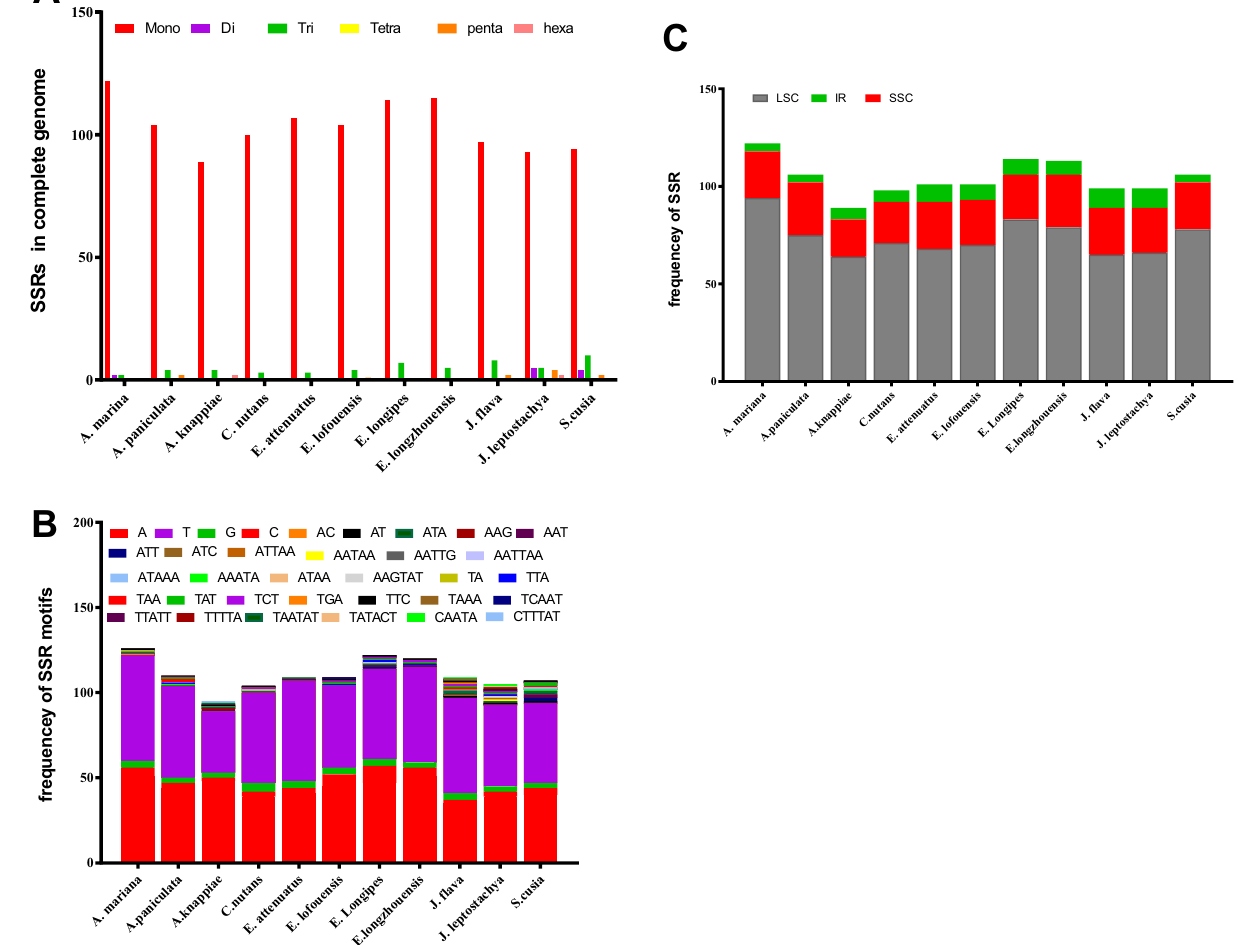
Figure 3. Simple sequence repeats (SSRs) analysis in the chloroplast genome of A. marina . ( A ) Numbers of SSR types in complete chloroplast genome, ( B ) Number of SSRs in LSC, IR and SSC regions. ( C ) frequency of SSR